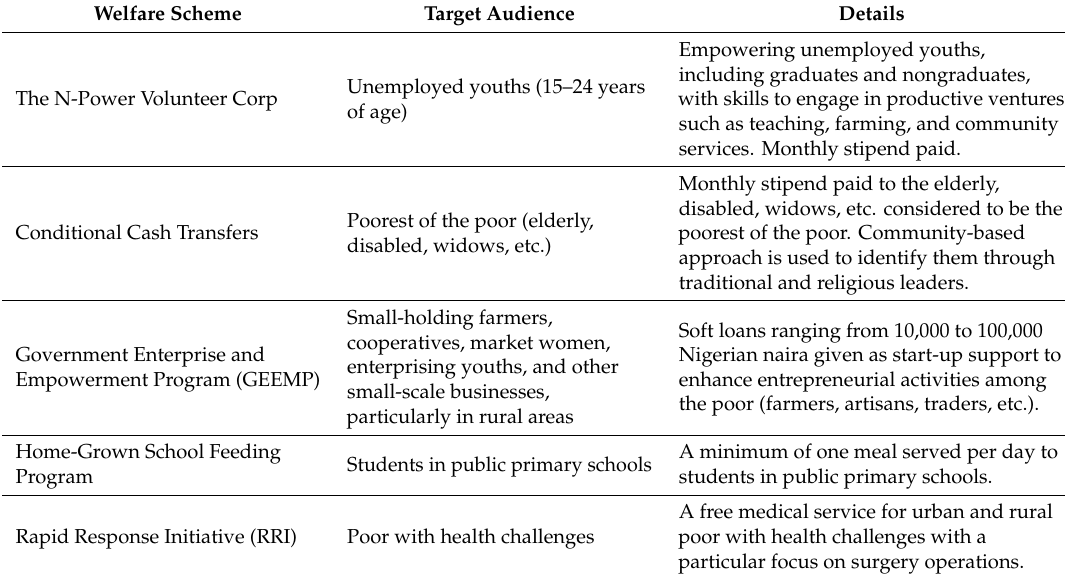
Table 1. Sample ongoing social investment programs in